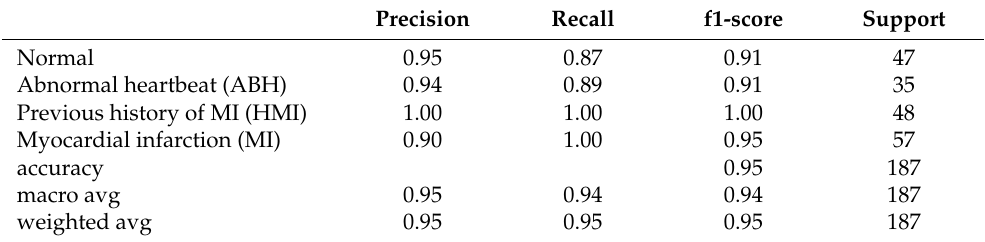
Table 9. Classification Rerort for VGG16